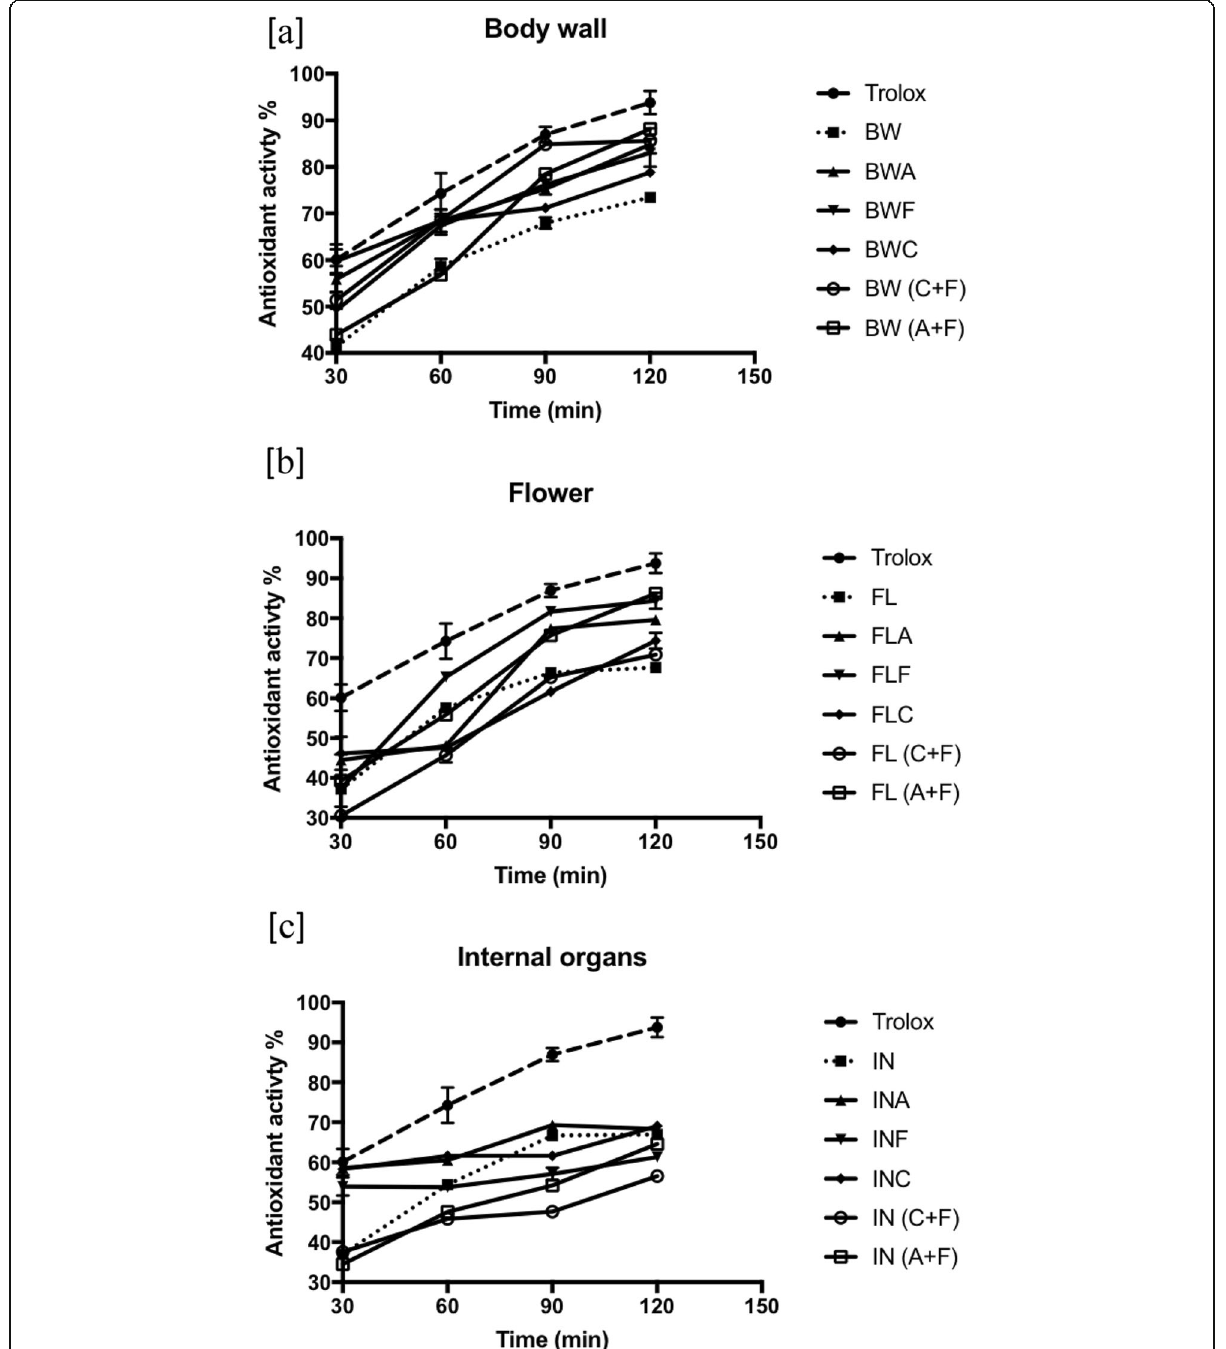
Fig. 7 Antioxidant activity of of sea cucumber C. frondosa protein hydrolysates in oil-in-water emulsion system a BW, Body wall; b FL, Flower; and c IN, Internal organs; A, Alcalase; F, Flavourzyme; C, Corolase; C + F, Mixture of Corolase and Flavourzyme; and A + F, Mixture of Alcalase and Flavourzyme. Different letters for the same concentration of all hydrolysates indicates significant difference at p <